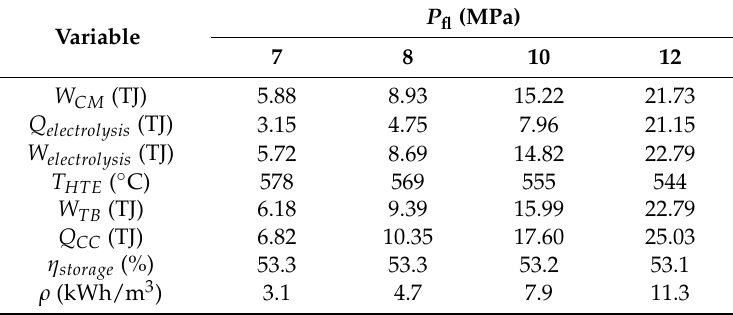
Table 5. Sensitivity of the CAES-HTE model to maximum storage pressure. Results are based on an ideal electrolyzer.